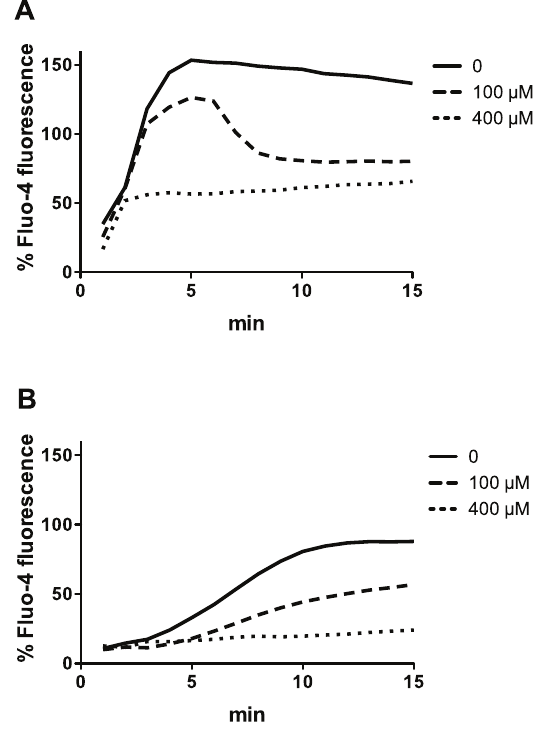
Figure 3. The effect of calcium channel blockade on calcium ion entry into human PMNs in presence of 20 nM PVL (A) or 500 nM LukGH (B). PMNs (2 6 10 6 /mL) were loaded with 4 m M Fluo- 4 in presence of 1.1 mM CaCl 2 and then exposed to the indicated concentration of methoxyverapamil for 60 min prior to adding PVL or LukGH. Calcium flux was then determined as described in Figure 1. The results represent the mean of three independent experiments.